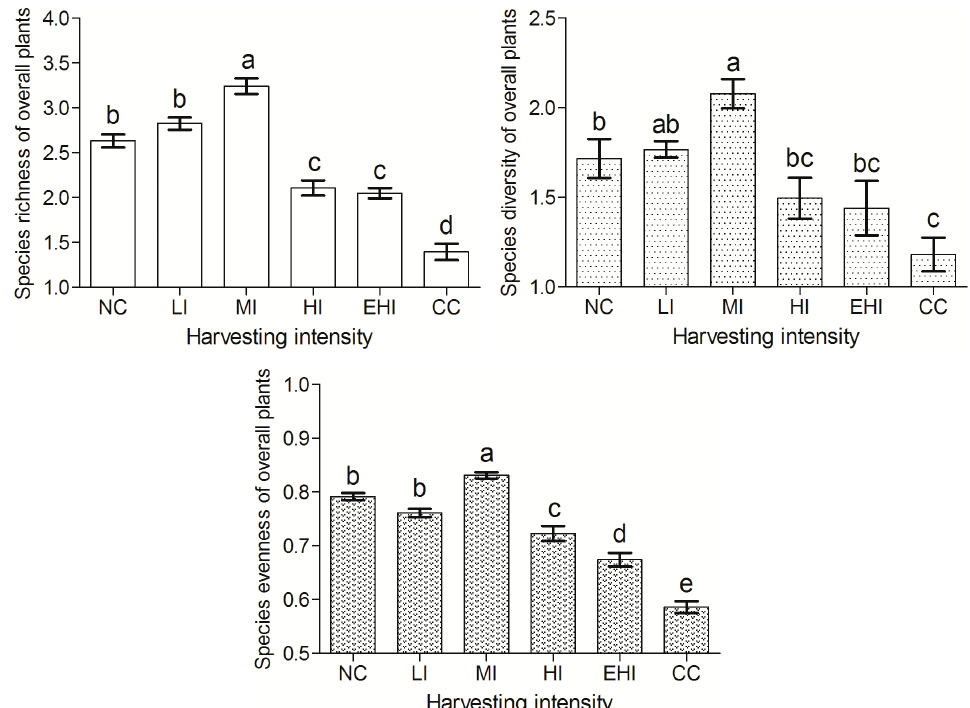
Figure 2. Results of multiple comparisons of diversity indices of overall plants 15 years after harvesting. Scheffe multiple test; the significance level was p < 0.05; Mean ± S.D; 95% confidence interval for mean. Letters indicate differences between different harvesting intensities. NC indicates non-harvesting; LI indicates selective harvesting at low intensity; MI indicates selective harvesting at medium intensity; HI indicates selective harvesting at high intensity; EHI indicates selective harvesting at extra-high intensity; CC indicates clear-cut